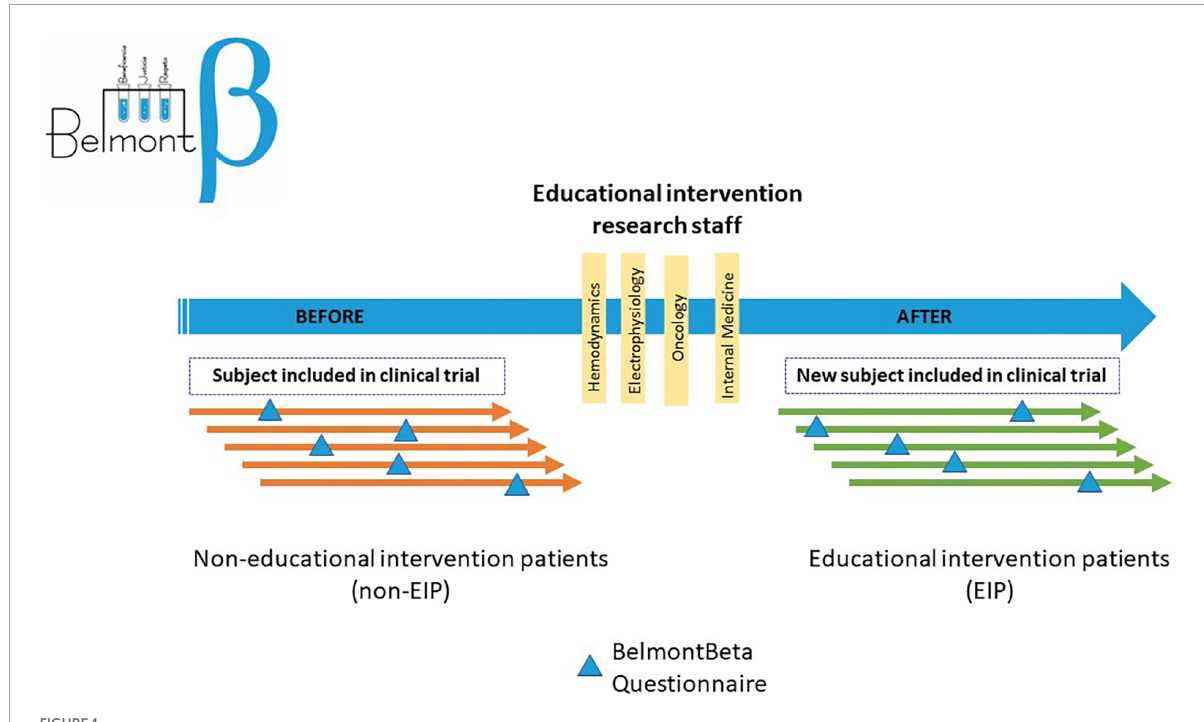
FIGURE1 Flow chart diagram of the